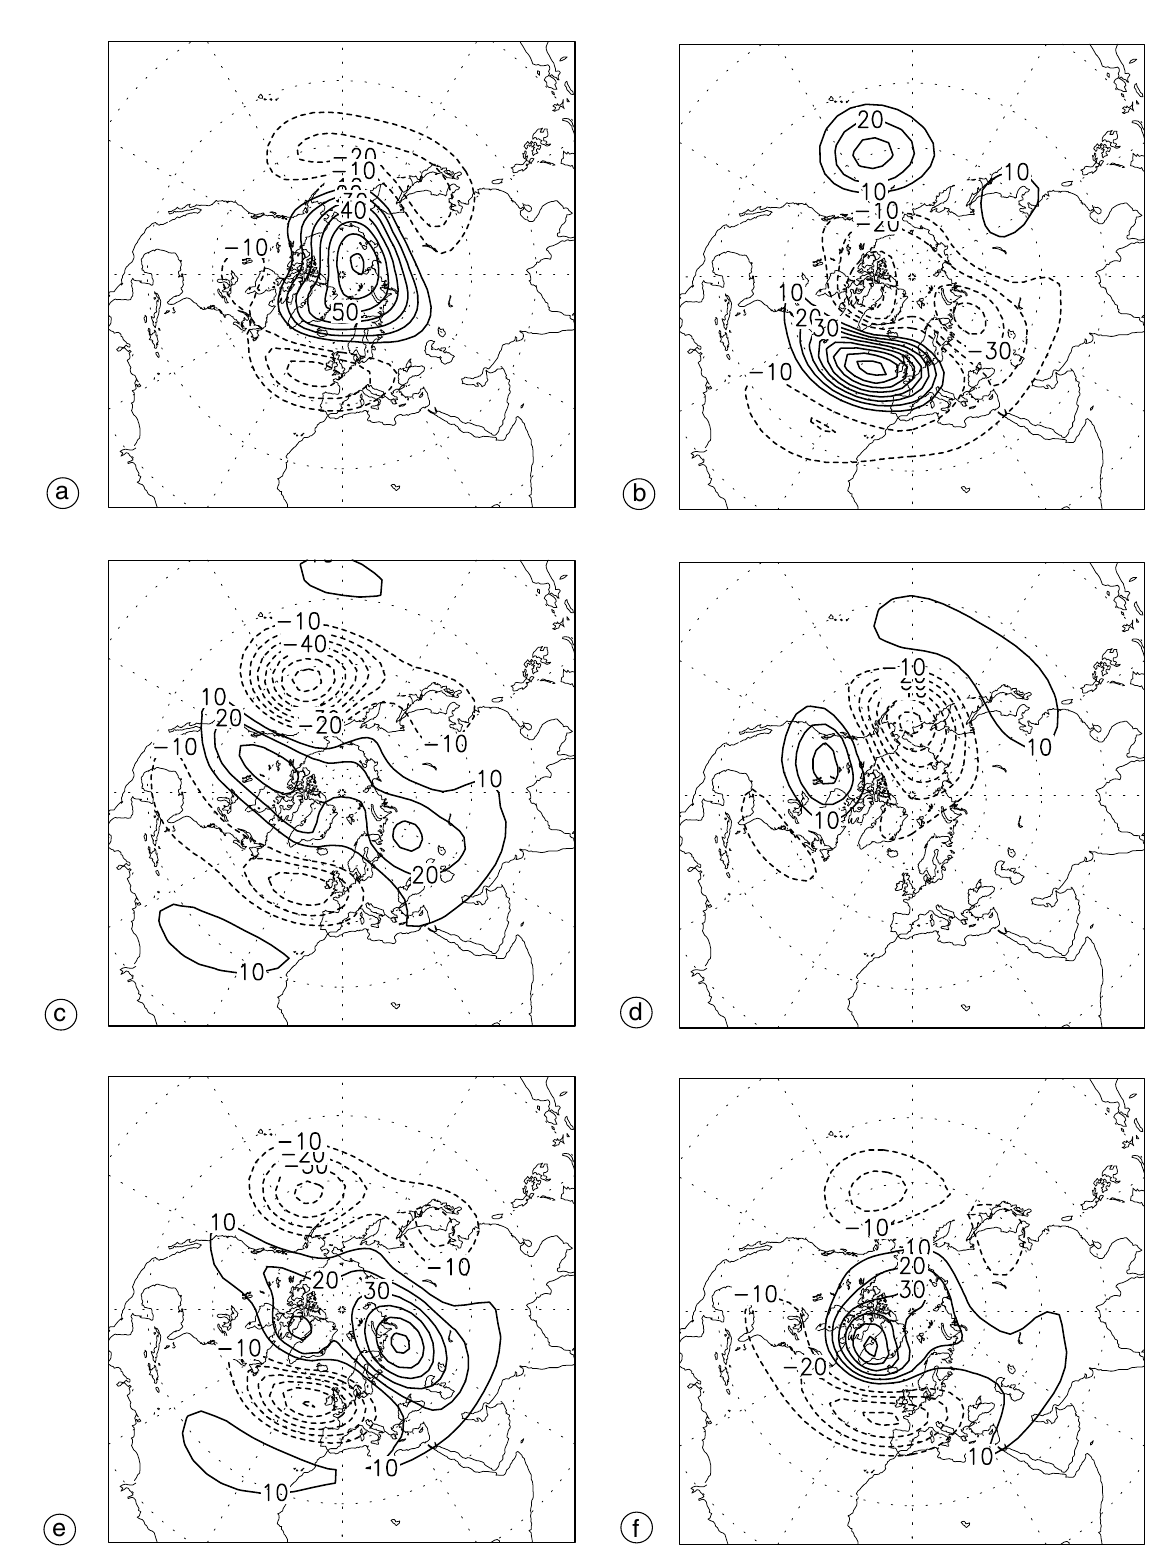
Fig. 6a-f. Common spatial structures obtained through the super-ensemble rotated EOF analysis for DJF-mean 500-hPa geopotential height in the Northern Hemisphere. The explained variance is respectively 16.2% (a); 13.4% (b); 12.3% (c); 10.7% (d); 9.5% (e), and 7.5% (f). Total variance is 302 m 2 s –2 . Units are in